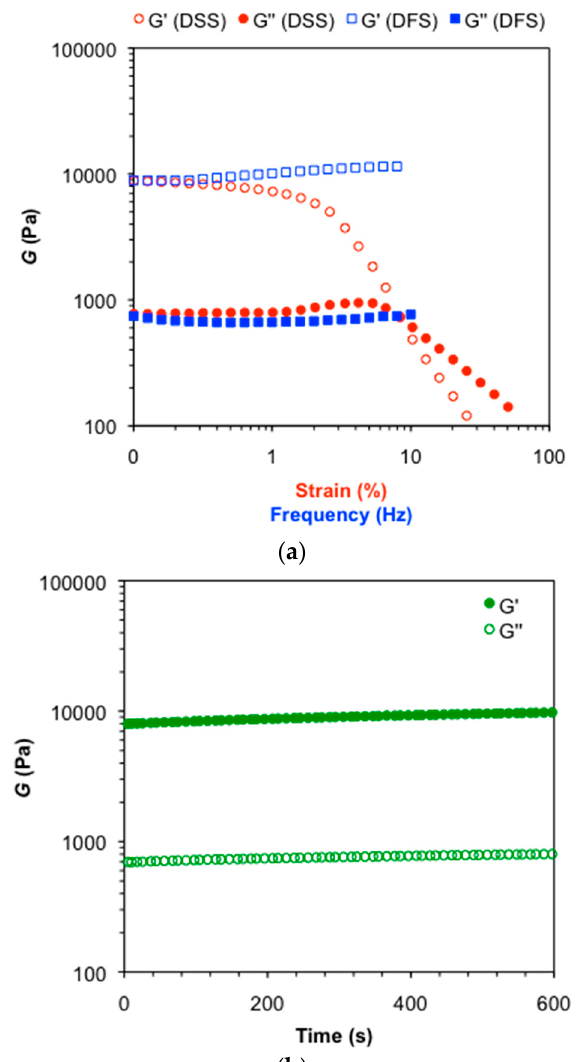
Figure 4. ( a ) Dynamic frequency sweep (DFS), dynamic strain sweep (DSS), and ( b ) dynamic time sweep (DTS) measurements for the model gel made of 14 in toluene (9 g/L). The tan δ (i.e., G ′′ / G ′ , damping coefficient) was reproducible in random experiments.